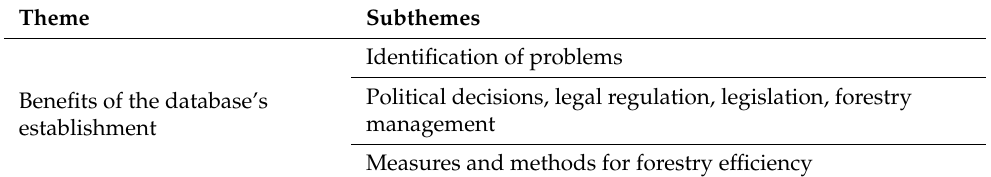
Table 1. The main benefits of establishing the